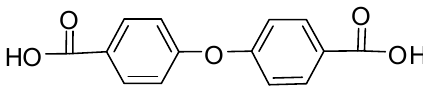
Figure 2. 4,4’-Oxybis(benzoic